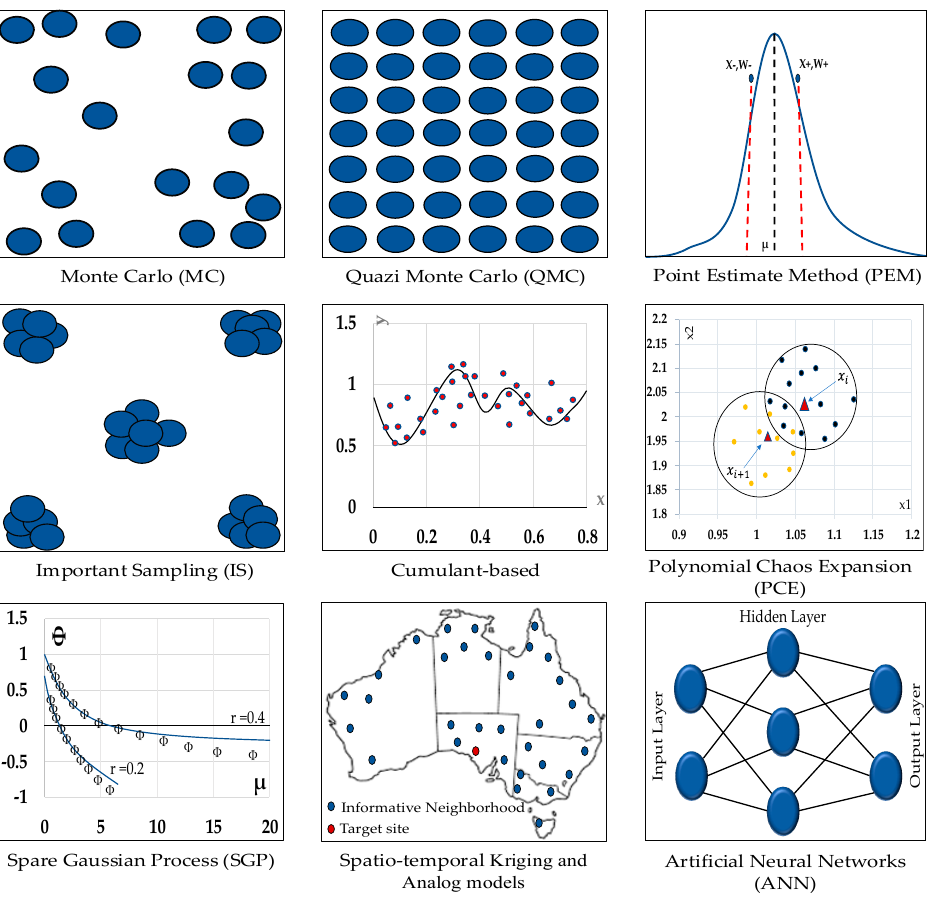
Figure 2. Random number generation techniques by the accurate and efficient UM techniques compared to the benchmark MC method.